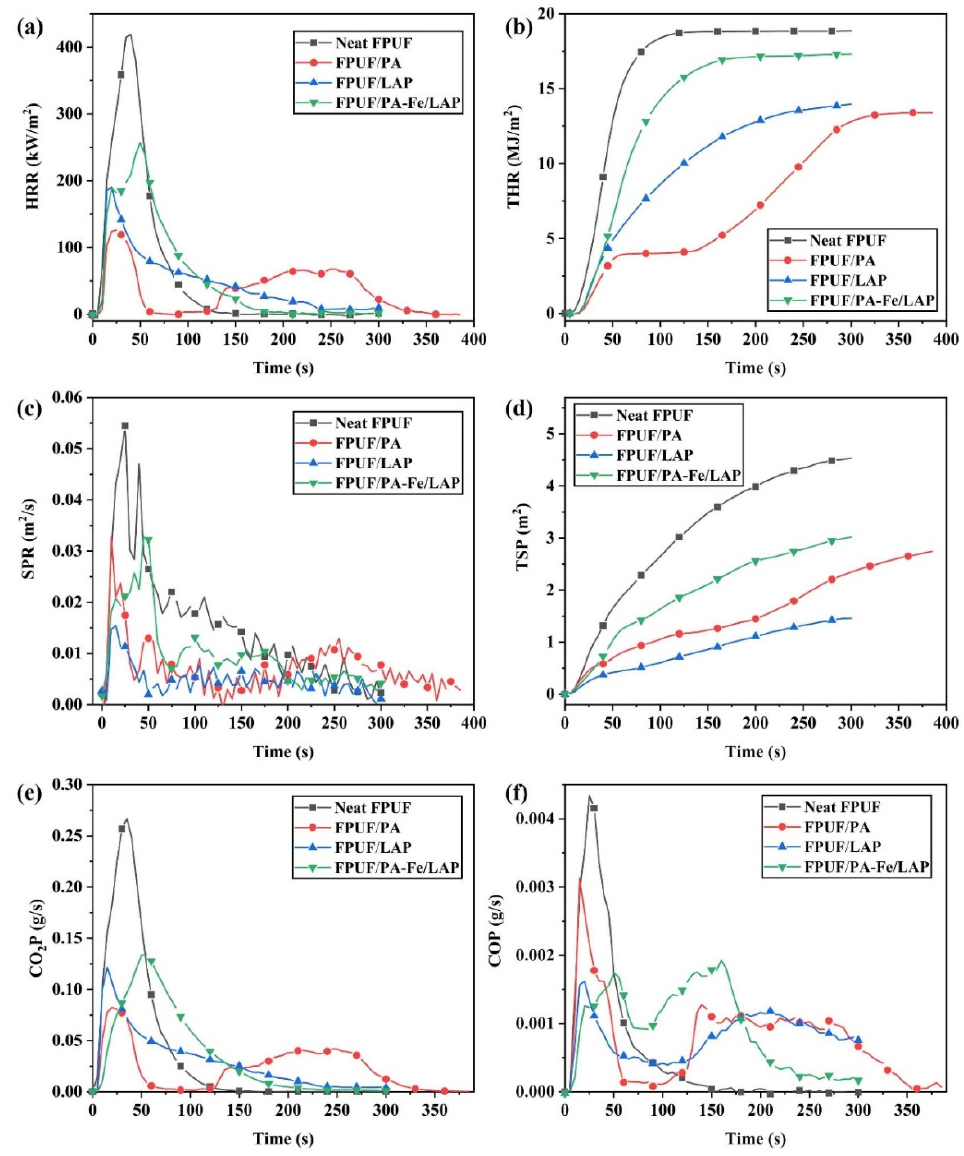
Figure 7. The HRR ( a ), THR ( b ), SPR ( c ), TSP ( d ), CO 2 P ( e ), and COP ( f ) curves for neat FPUF, FPUF/PA, FPUF/LAP, and FPUF/PA-Fe/LAP by